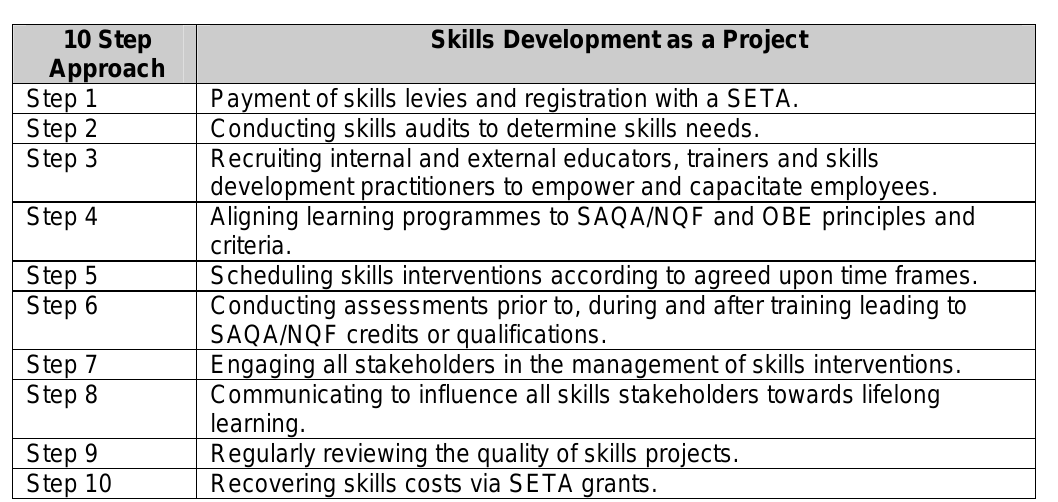
Table 3: Managing skills development as a project